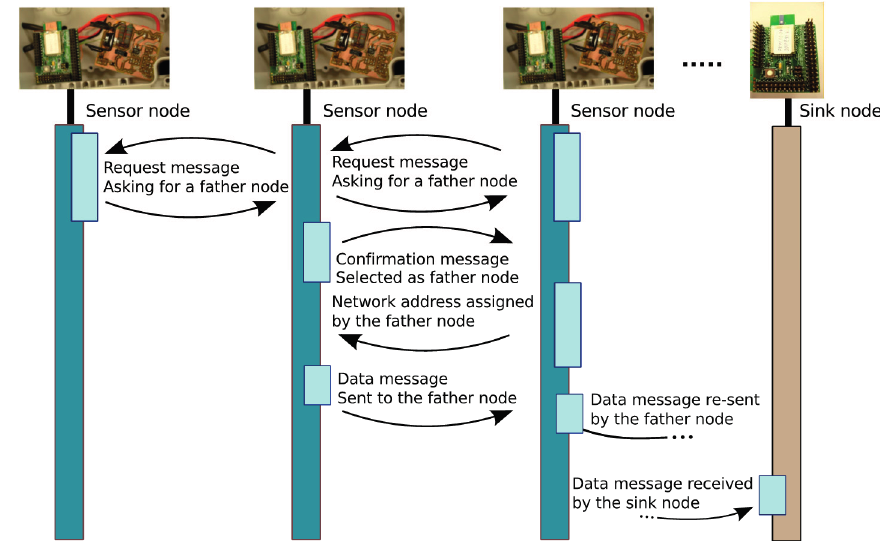
Figure 3. Multi-hop communication through sensor and sink